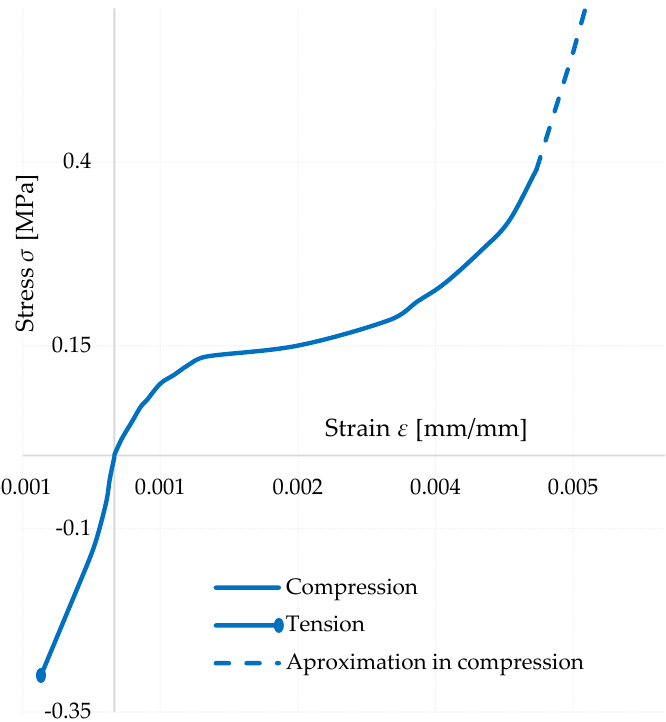
Figure 18. Stress–strain diagram– FC500 used for evaluation.